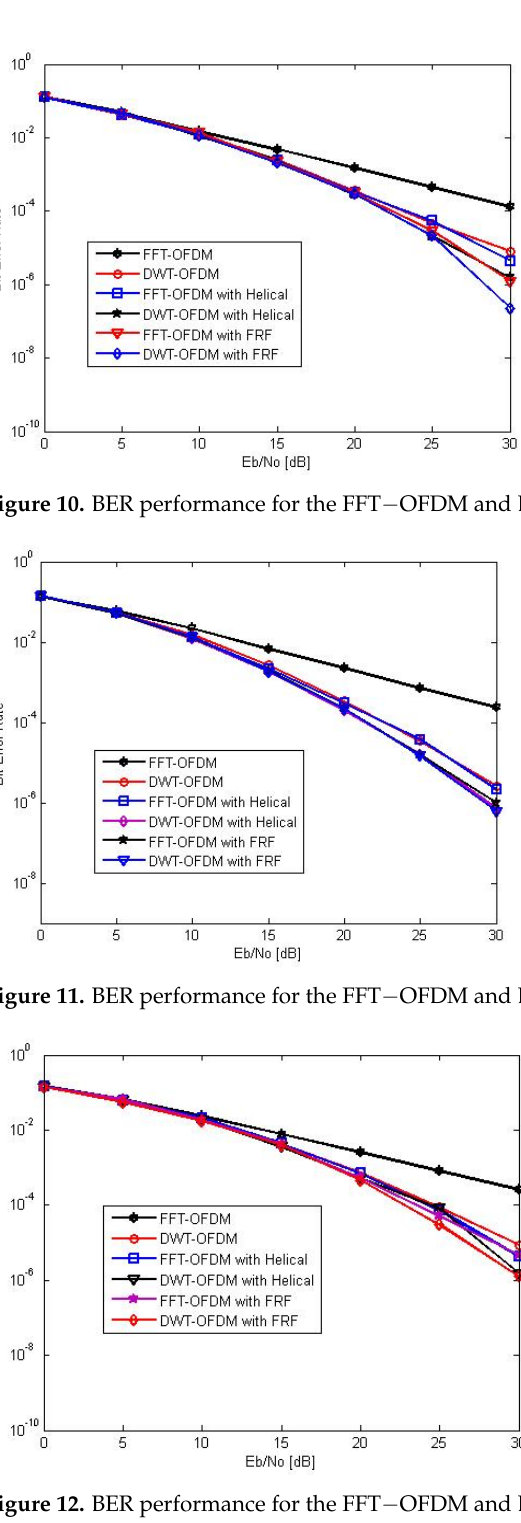
Table 4. Multipath profile of the vehicular A outdoor channel